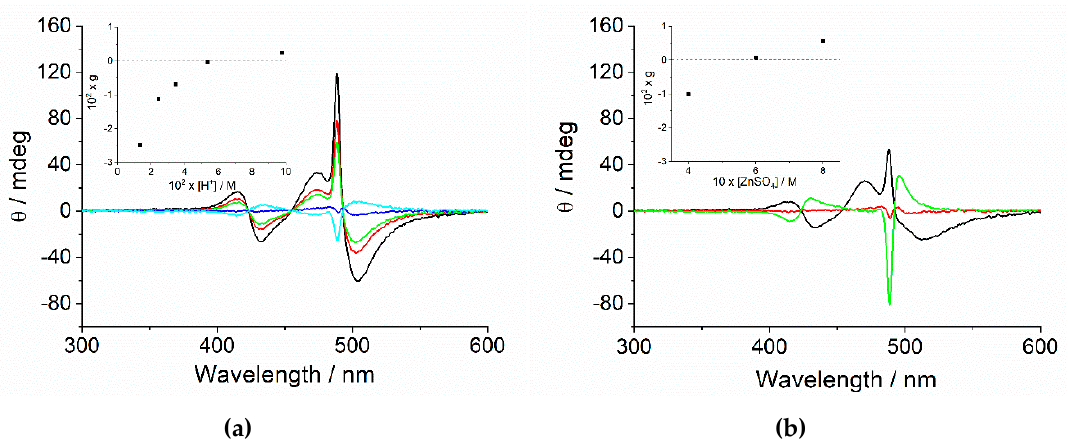
Figure 7. CD spectra of the samples at the end of the aggregation process for the experiments at variable [H + ] and fixed ionic strength (IS = 0.6 M) ([H 2 SO 4 ] = 0.01 (black), 0.02 (red), 0.03 (green), 0.05 (blue) and 0.1 M (cyan)) ( a ) and at variable ionic strength and fixed [H + ] ([H 2 SO 4 ] = 0.05 M) ([ZnSO 4 ] = 0.4 (black), 0.6 (red) and 0.8 M (green)). The inset of both frames reports the plots of the asymmetry g-factor at the J-couplet (490 nm) as function of [H + ] ( a ) and [ZnSO 4 ] ( b ).